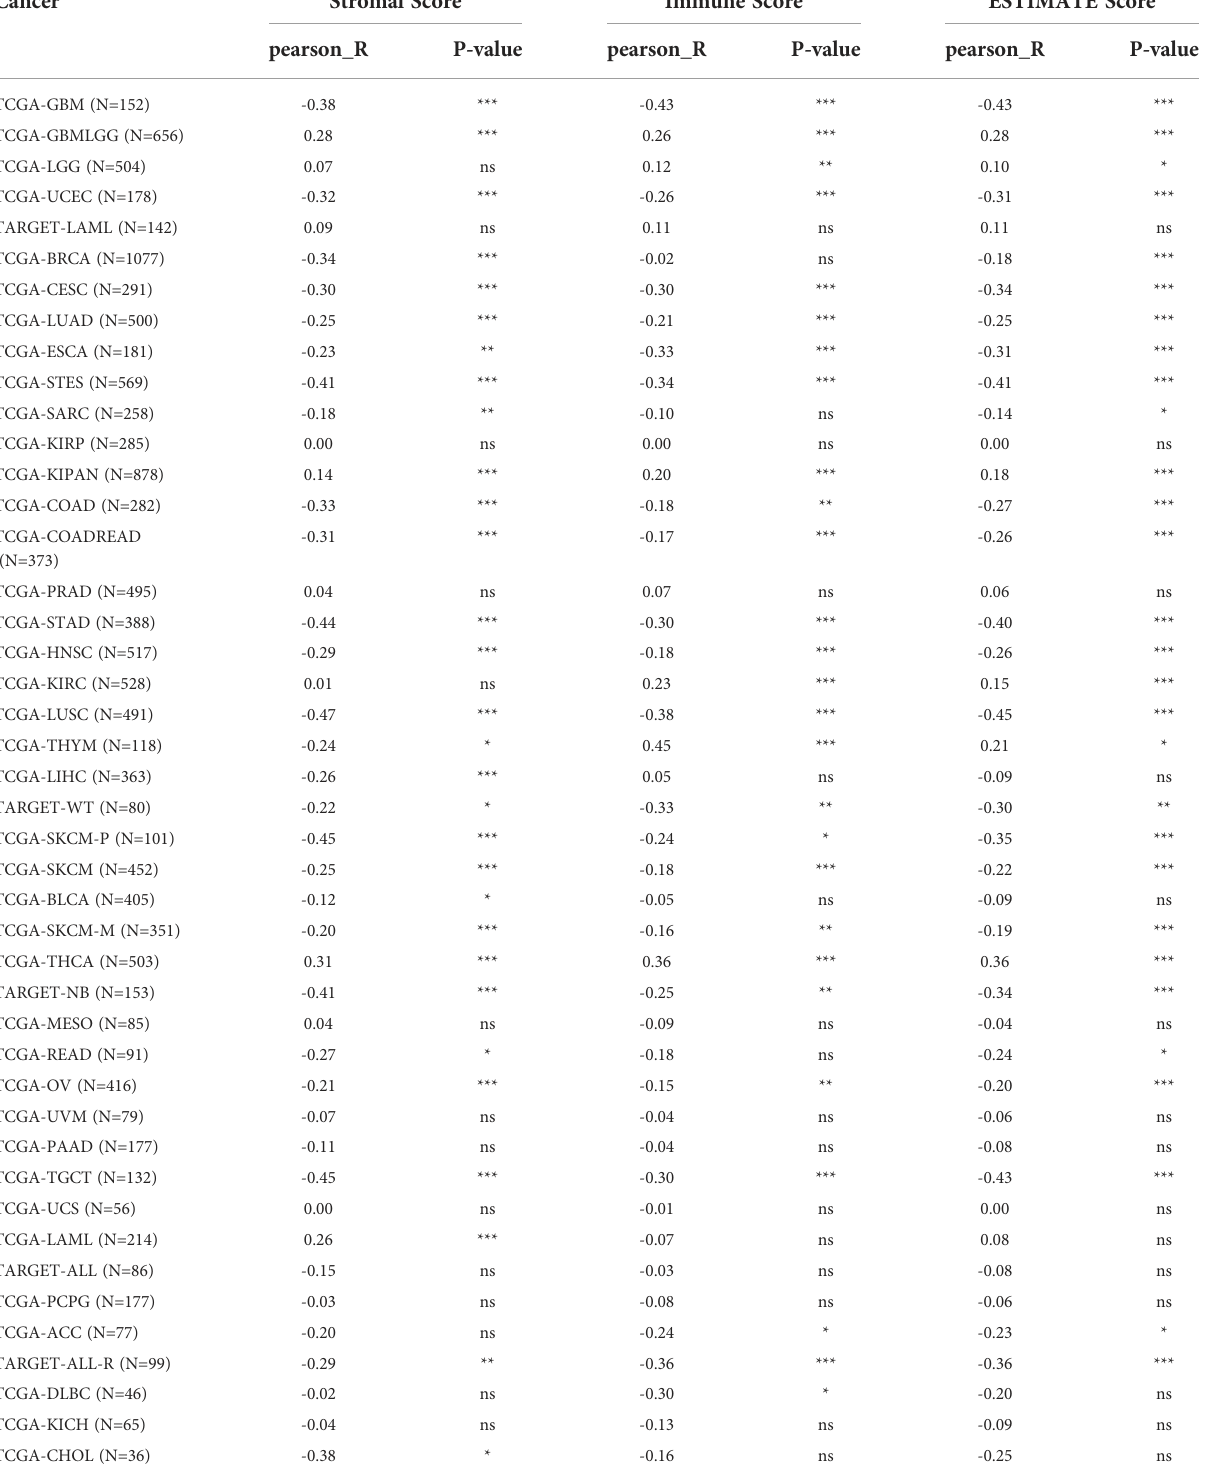
TABLE 1 Correlation analysis of TROAP expression with ESTIMATE scores in pan-cancers according the RNA sequencing data from TCGA database.